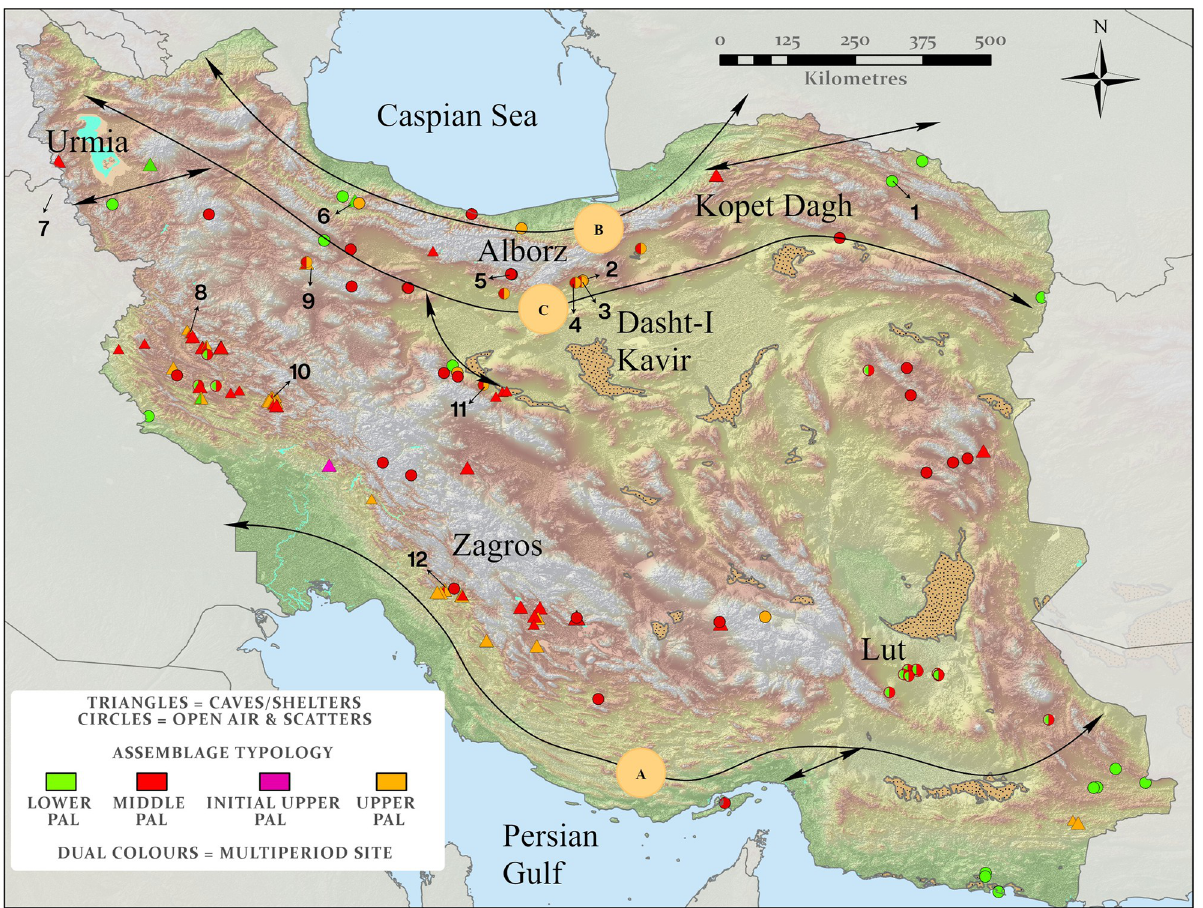
Fig 1. The distribution of key Paleolithic sites in Iran differentiated by lithic typology. The sites are overlain on elevation data (SRTM), progressing from low (green) to high (white) altitudes. The brown speckled polygons mark dune fields. Regions referenced in the text are labelled. Dispersal routes (A-C) previously suggested by Vahdati Nasab et al. [13] are marked as black arrows. The location of archaeological sites discussed in the text is numbered as follow; 1. Kashafrud, 2. Chah-e Jam, 3. Mirak, 4. Soofi Abad, 5. Moghanak and Otchunak, 6. Darband, 7. Shanidar, 8. Bawa Yawan, 9. Qaleh Kurd, 10. Kaldar, 11. Qaleh Gusheh, 12. Ghar-e Boof. Map created by one of our authors